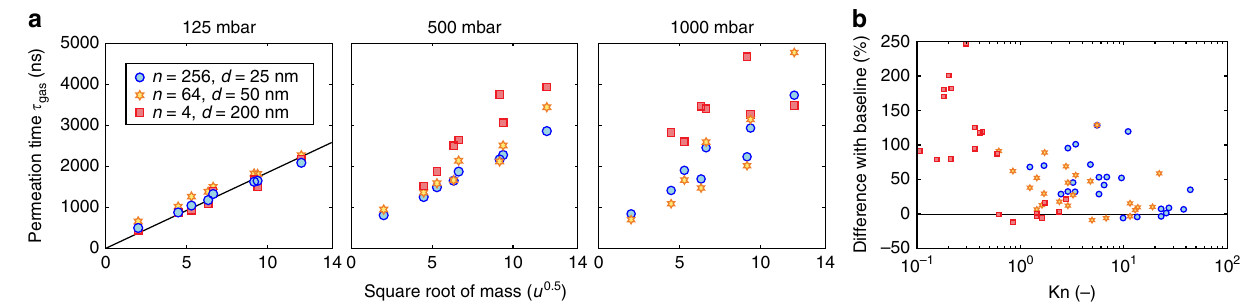
Fig. 5 Transition from Knudsen to Sampson fl ow. To compare different Knudsen numbers, the pore diameter d and number of pores n are varied, maintaining constant total pore area. Permeation times are shown in the transitional region between Knudsen and Sampson fl ow at a Kn range of 0.1 – 100. a At P = 125 mbar all devices follow Graham ’ s law, as indicated by a fi t to a straight line through the origin. At higher pressures, the measurements deviate from a straight line. b The difference with respect to the black baseline in a is calculated for all measurements shown in a . As Kn drops below 1, the permeation time increases and Graham ’ s law does no longer describe the values of τ